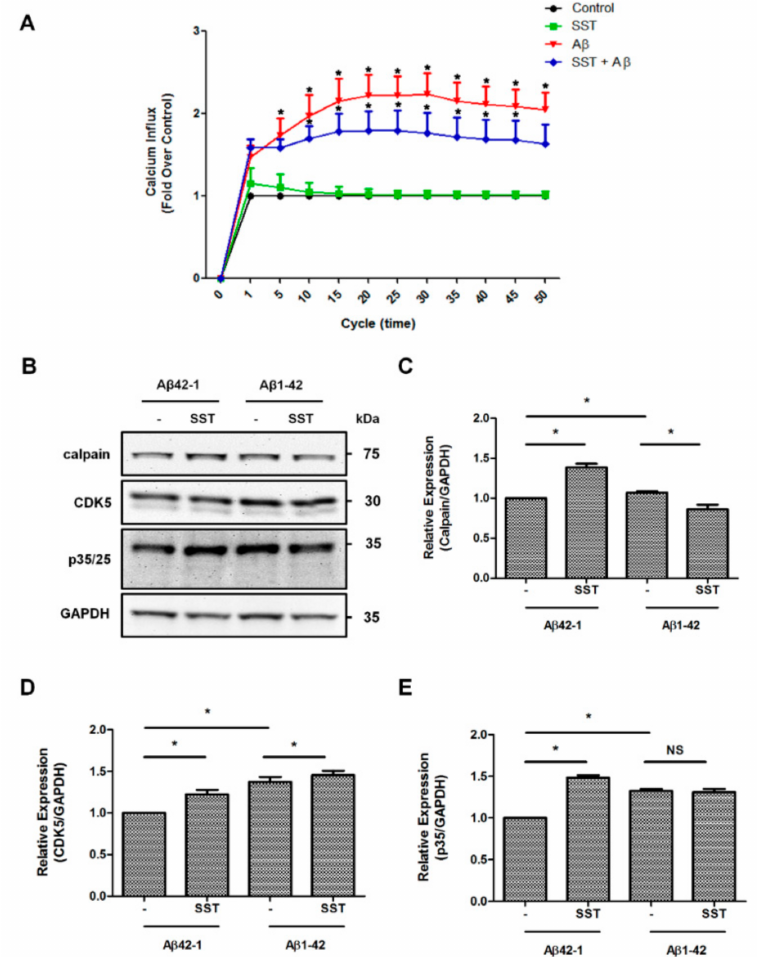
Figure 7. SST-mediated effects on calcium signaling and downstream mediators. ( A ). The intracellular level of Ca 2+ was assessed using the Fluo-4 calcium indicator. Cells treated with A β 1-42 resulted in an increased Ca 2+ influx compared to the SST or untreated control. Cells treated with A β 1-42 in the presence of SST resulted in a noticeable inhibition of the Ca 2+ influx compared to the cells treated with A β 1-42 alone. B. Representative Western blot displaying the changes in the expression of calpain, CDK5, and p35/25 expression in cells treated with A β 1-42 in the presence or absence of SST. ( C – E ). Histograms represent the densitometry analysis of the Western blot shown in ( B ). Data represent the mean ± SD of three independent experiments. * p < 0.05 against respective control, Two-way ANOVA with Bonferroni post-hoc